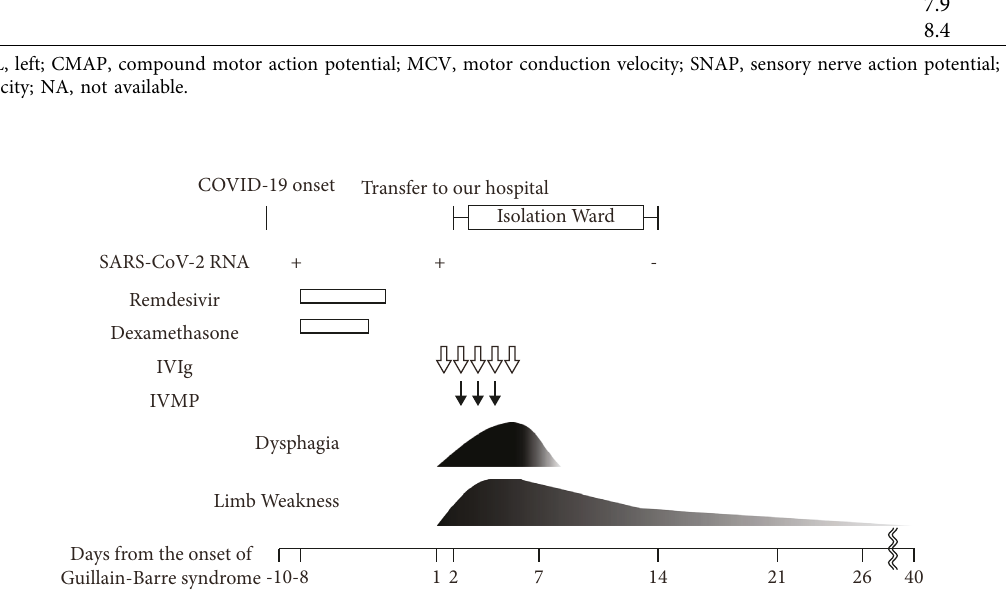
Figure 1: Clinical course of the disease. The diagram shows the clinical severity of dysphagia and weakness of the limbs from the onset of Guillain–Barr´e syndrome on day 1. The arrows indicate Guillain–Barr´e syndrome treatment with intravenous immunoglobulin (white) and intravenous methylprednisolone (black). On day 7, he showed severe muscle weakness in his neck and extremities, dysphagia, and re- spiratory difficulties. Thereafter, each symptom improved, and he was discharged on day 40 with minimal muscle fatigue. Abbreviations: IVIg, intravenous immunoglobulin; IVMP, intravenous methylprednisolone; SARS-CoV-2 RNA, severe acute respiratory syndrome coronavirus 2 ribonucleic acid.